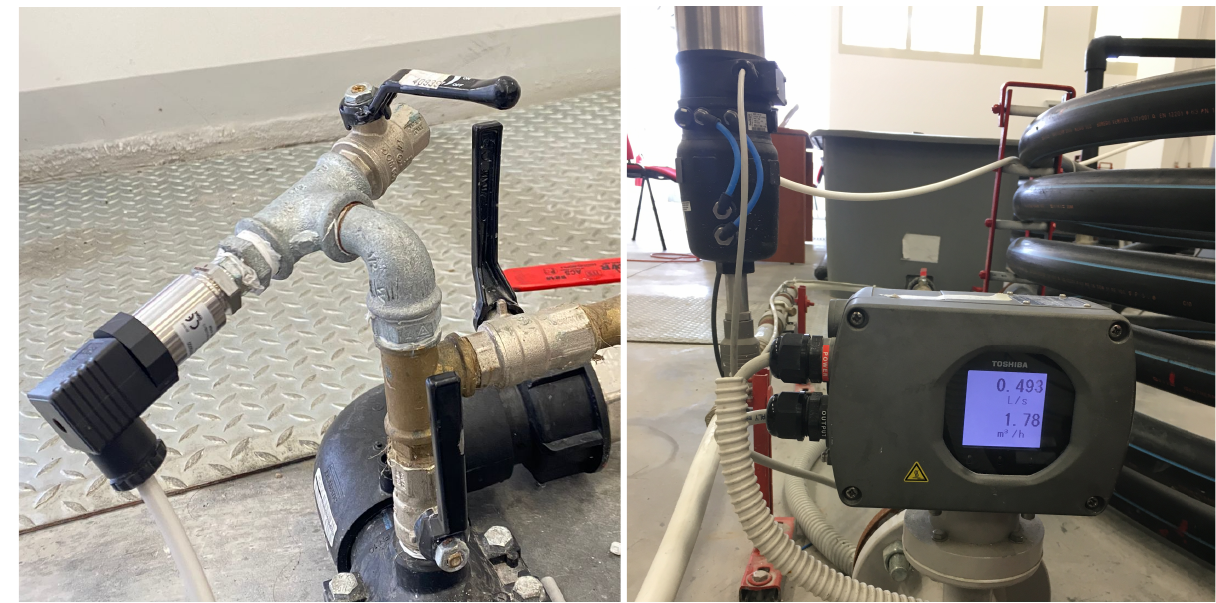
Figure 2. ( Left ): Pressure transducer installed in a node of the LIA water distribution network. ( Right ): Electromagnetic flow